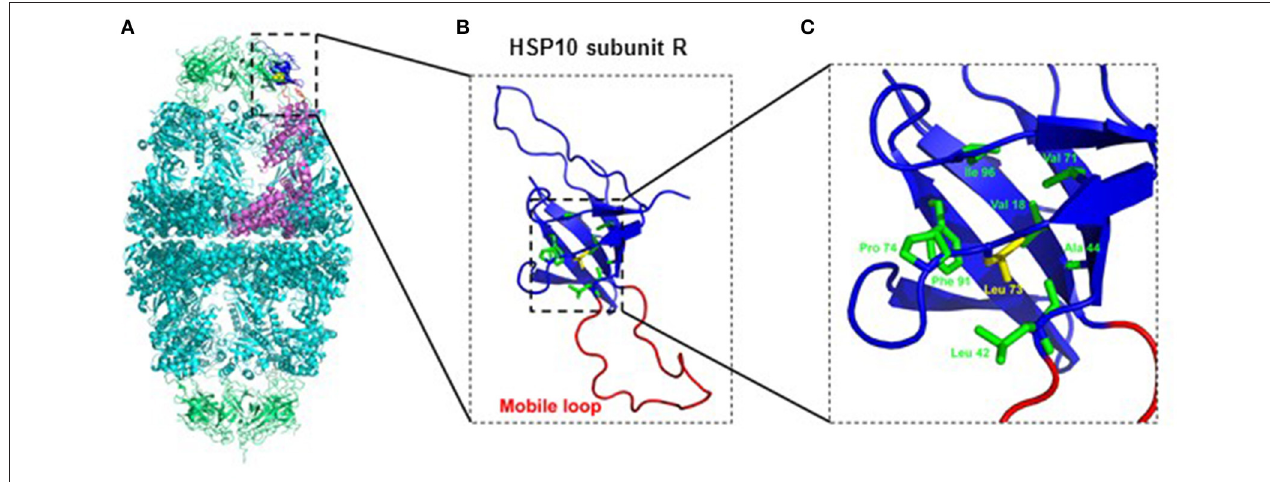
FIGURE 1 | Position of Leucine-73 in the HSP60/HSP10 complex structure. (A) HSP60-HSP10 symmetric football complex shown in cartoon representation. HSP60 subunits are in cyan and HSP10 subunits are in green. One HSP60 subunit (subunit D) and its interacting HSP10 subunit (subunit R) are emphasized (purple and blue respectively). The mobile loop of subunit R is in red. Leucine-73 residue is depicted in yellow with space filling representation. (B) Enlarged view of the boxed area in (A) displaying HSP10’s subunit R. Color scheme as in (A) . Leucine-73 and its interacting residues at the hydrophobic core of HSP10 (green) are presented as sticks. (C) Enlarged view of the boxed hydrophobic core of HSP10 from figure (B) . Leucine-73 and its interacting residues are labeled. Leucine-73 is facing the hydrophobic core made by the beta-sheets building HSP10 main body. In addition, analysis of Leucine-73 interactions in all HSP10 subunits using the PISA and